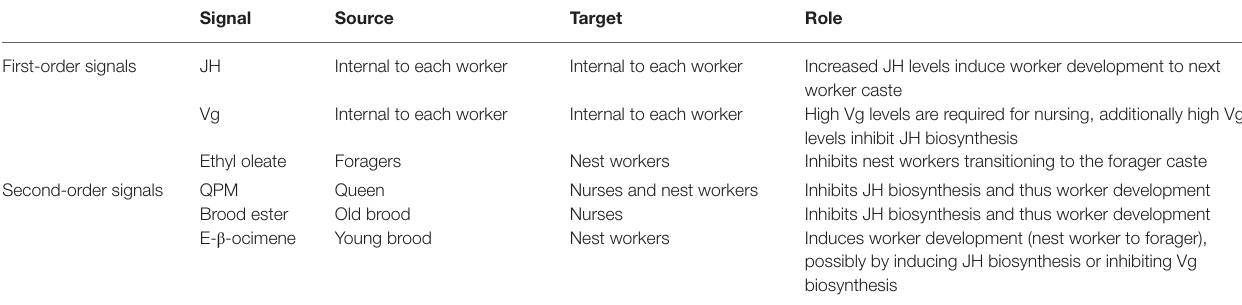
TABLE 1 | Temporal polyethism and caste ratio control in A. mellifera.